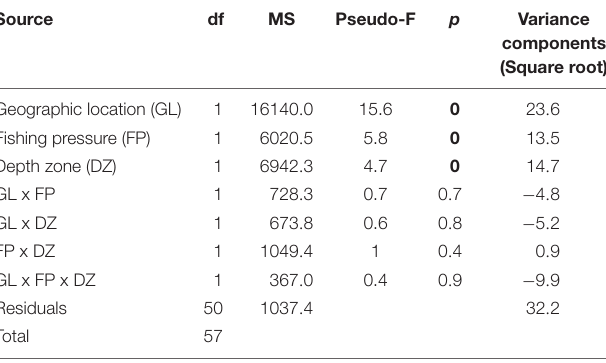
TABLE 6 | PERMANOVA results of rocky reef fish community structure in relation to geographic location, fishing pressure, and depth zone, based on square root transformed biomass